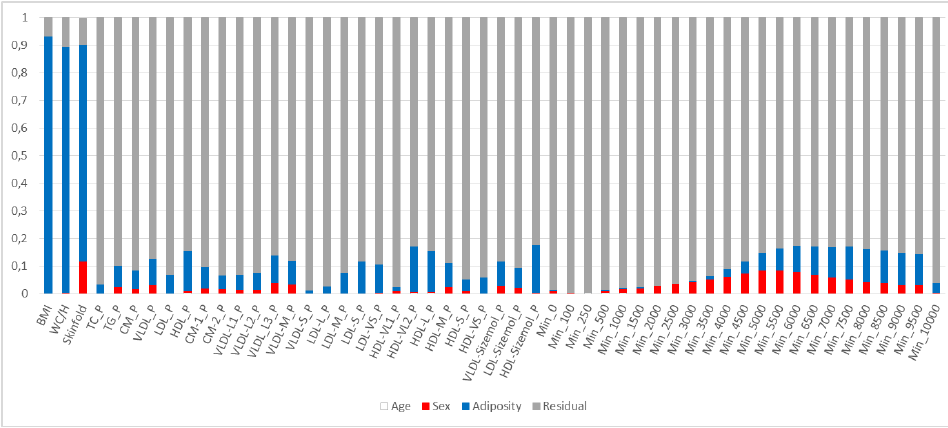
Figure A1. Variance plot displaying explained variance by the covariates age, sex, and adiposity. The covariate adiposity is the first principal component (PC) obtained for the three adiposity measures BMI, WC/H, and skinfold. This PC explained 88.1% of the total variance of the adiposity measures. Only this PC possessed predictive information about adiposity. For the physical activity variables, the names imply the lowest intensity levels in each intensity interval defined in Section 2.3. For instance, the name Min_0 implies the intensity interval 0–99